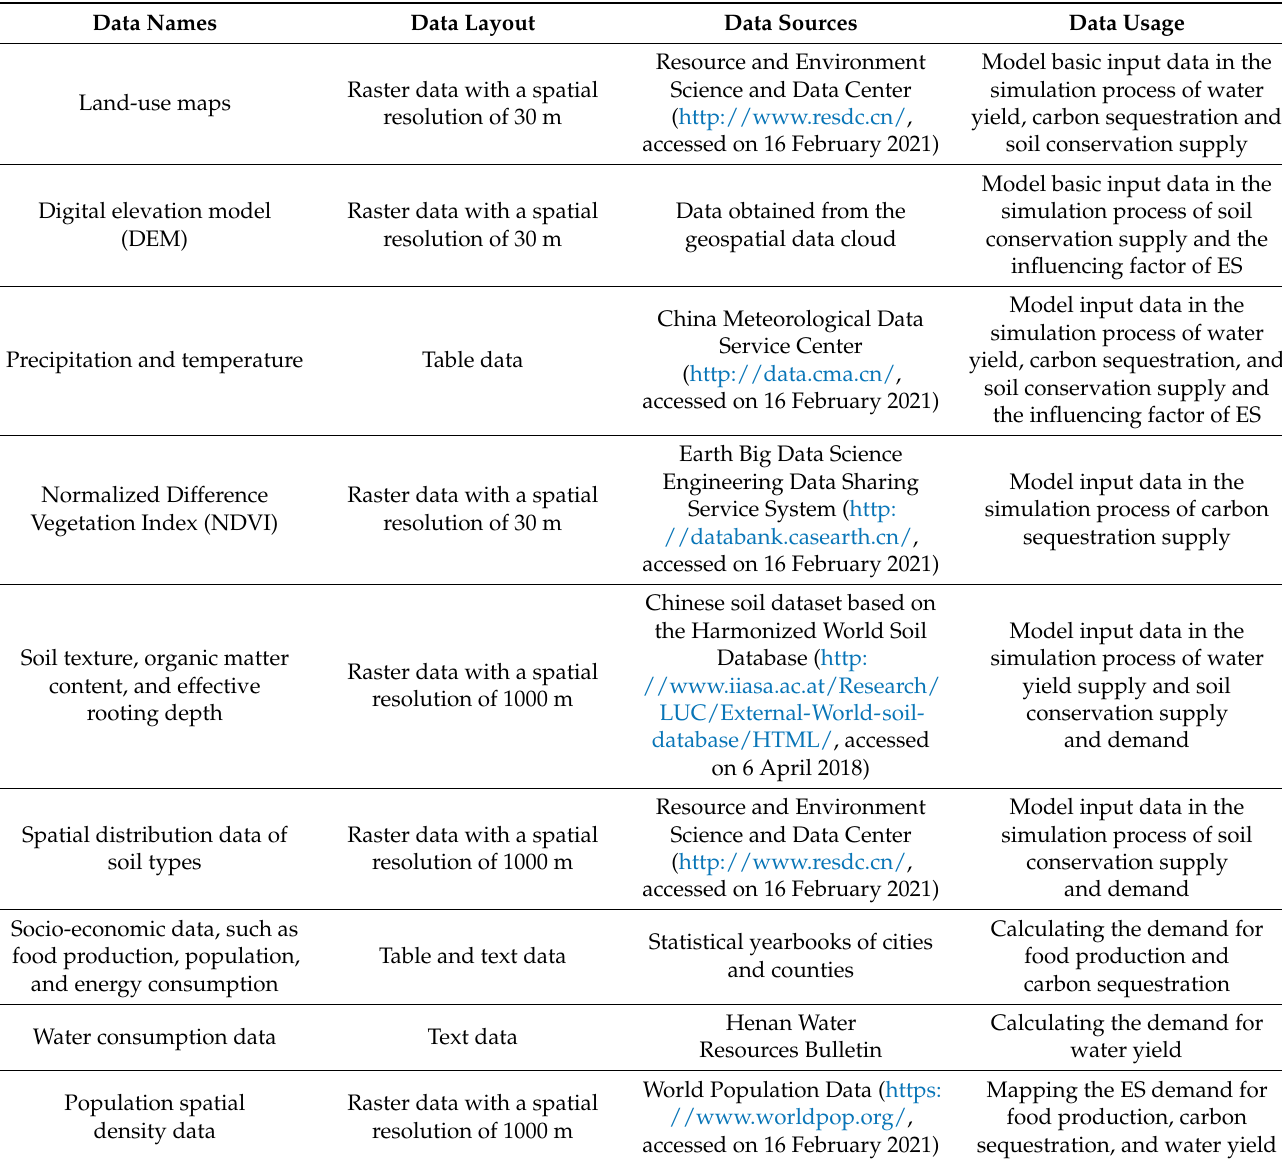
Table 1. Data description used for ecosystem service supply and demand